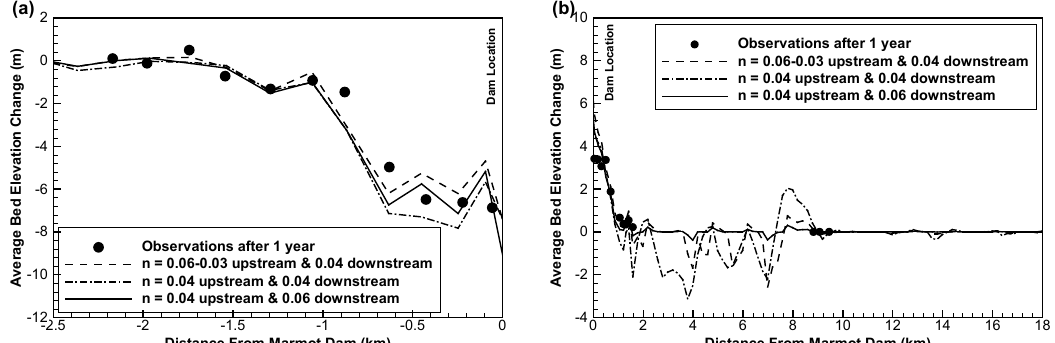
Fig. 4 Comparisons of 1-year bed changes using different roughness coefficients.